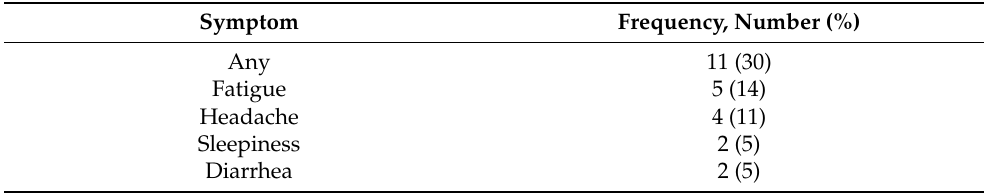
Table 3. Side effects of LDV/SOF treatment in 37